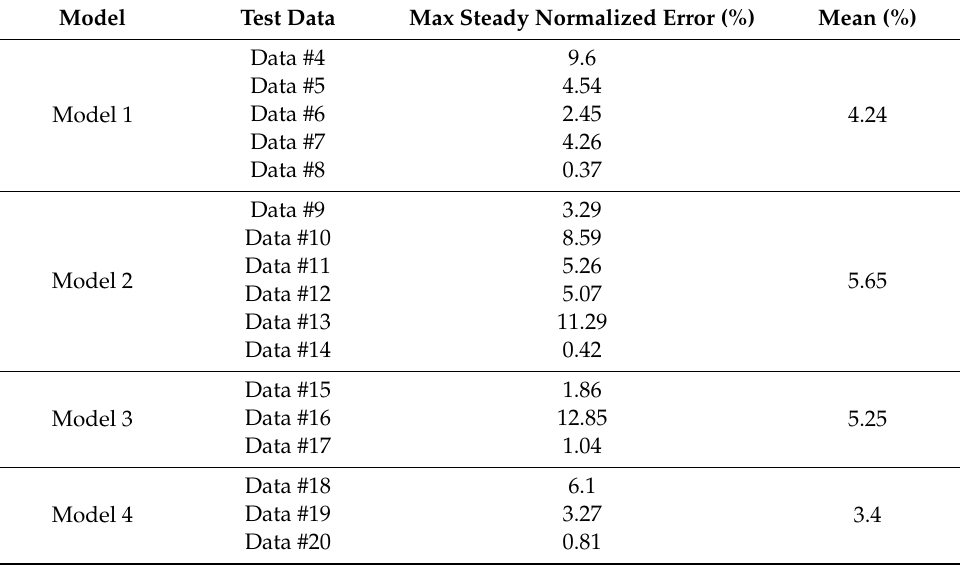
Table 7. Normalized errors of the trained